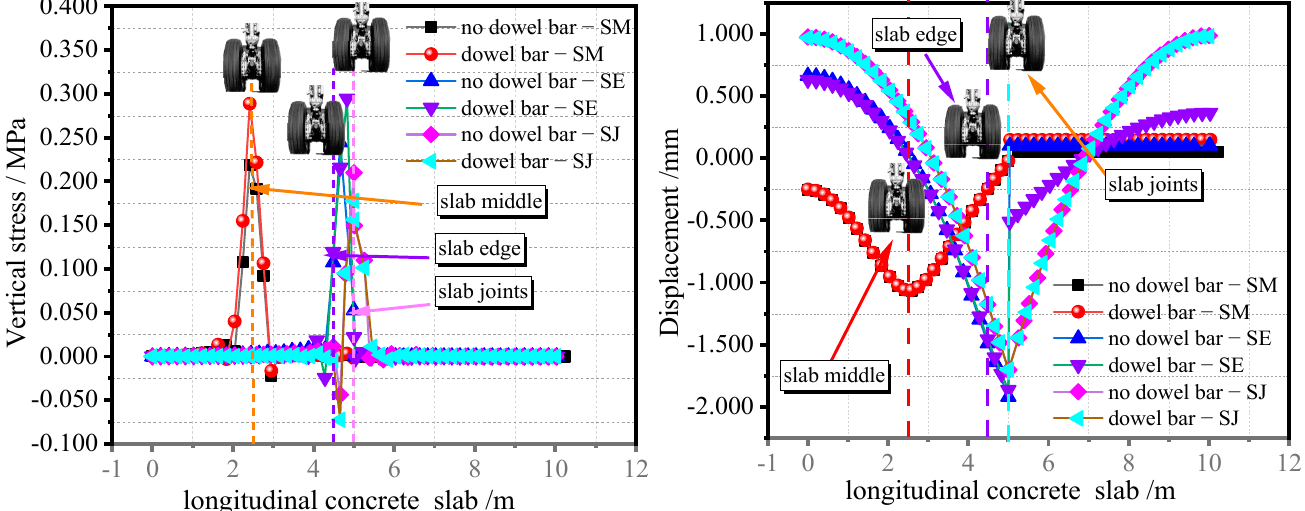
Figure 12. Comparison of stress states caused by the aircraft’s wheel load acting on different positions of the pavement slab. Table 4. Stress values at different positions of pavements.